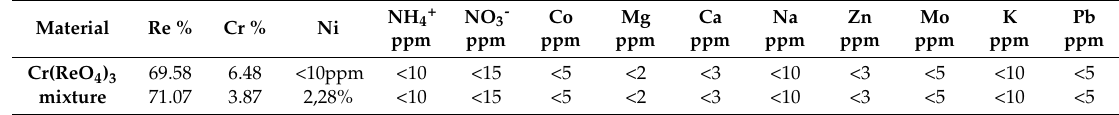
Table 7. Composition of chromium(III) perrhenate and its mixture with nickel.